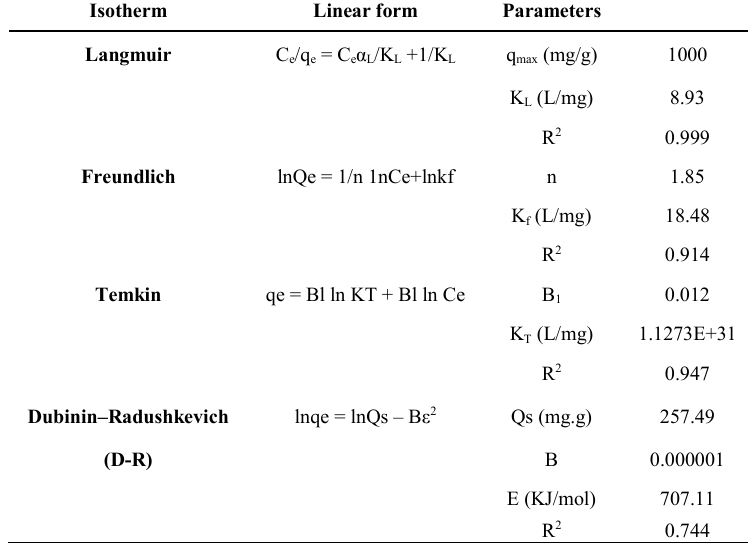
Table 3: Various isotherm constants and their correlation coefficients calculated for the adsorption of EBT onto ATPO-NPs